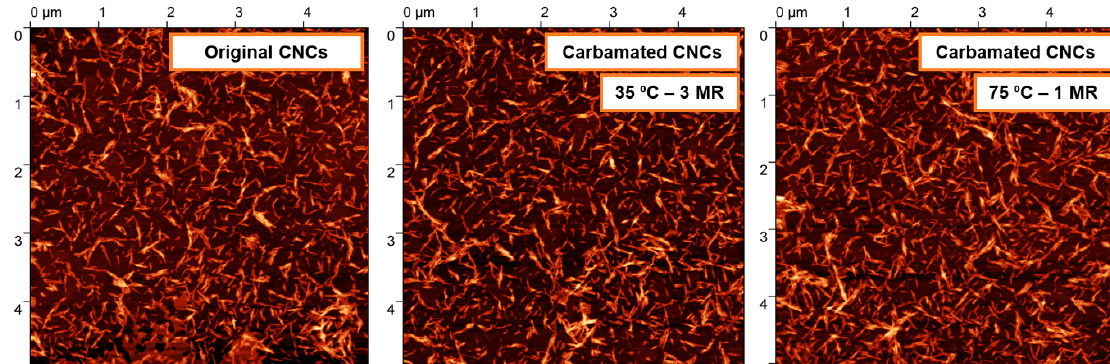
Figure 8. AFM topography images of CNCs before and after carbamation indicating no significant agglomeration or change in morphology. MR stands for TDI/CNCs molar ratio.